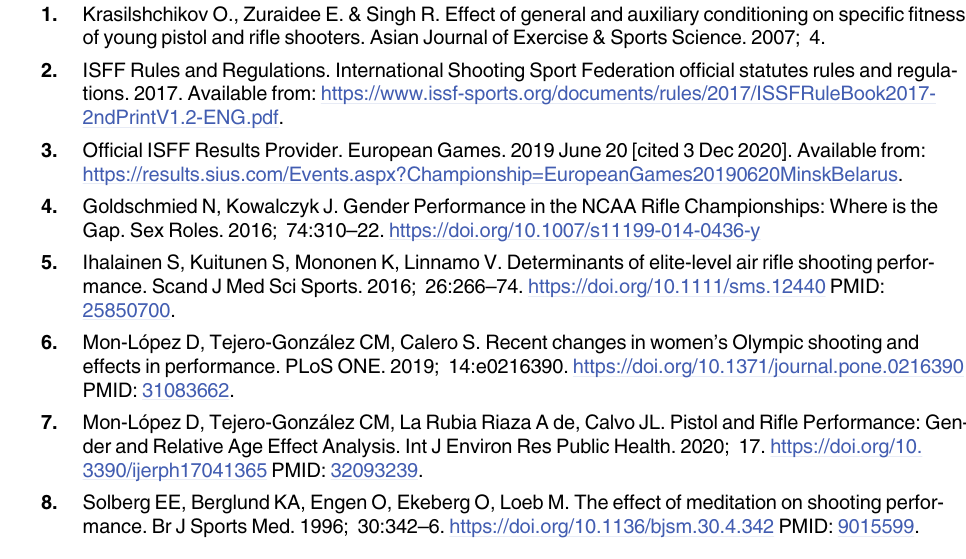
S1 Table. PRISMA checklist. S2 Table. Quality